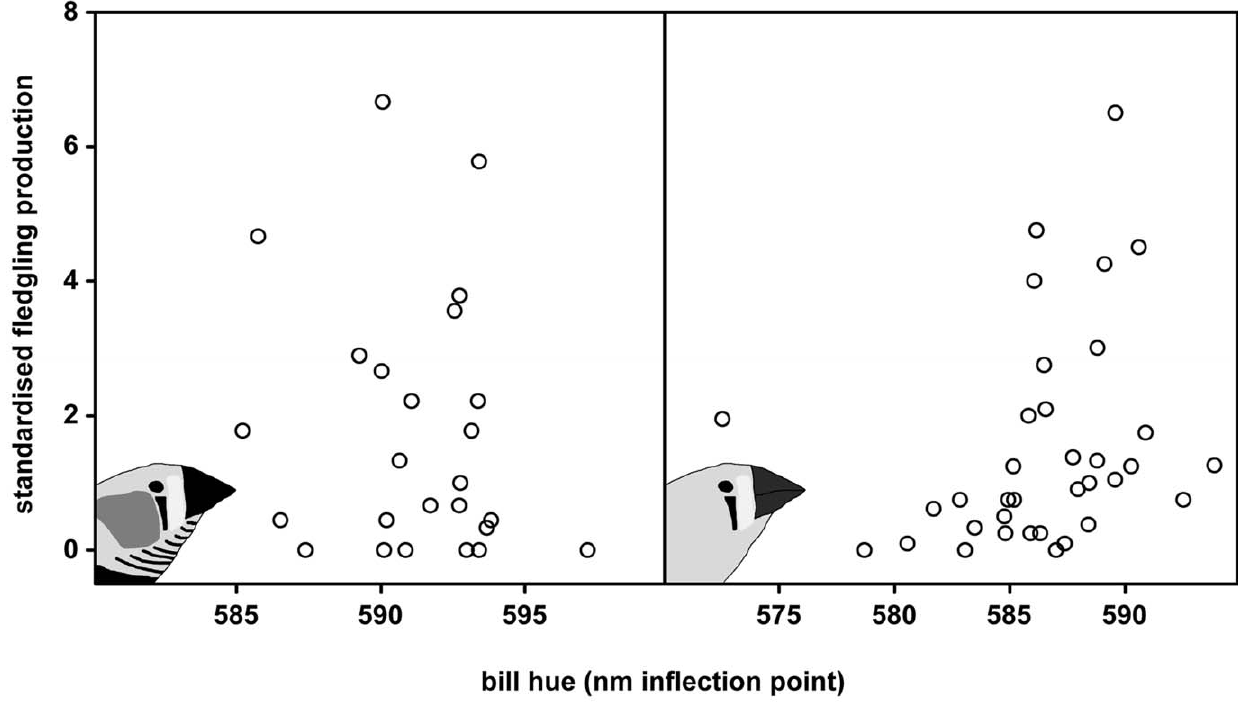
Figure 2. Bill hue and fledgling production. Fledgling production (standardised by dividing it by the median fledgling production per batch, thus not corrected for differences in longevity; see main text) of males (left panel) and females (right panel) in relation to bill hue. Only in females was redder bill hue significantly associated with reproductive success (see main text). doi:10.1371/journal.pone.0040721.g002 PLoS ONE |